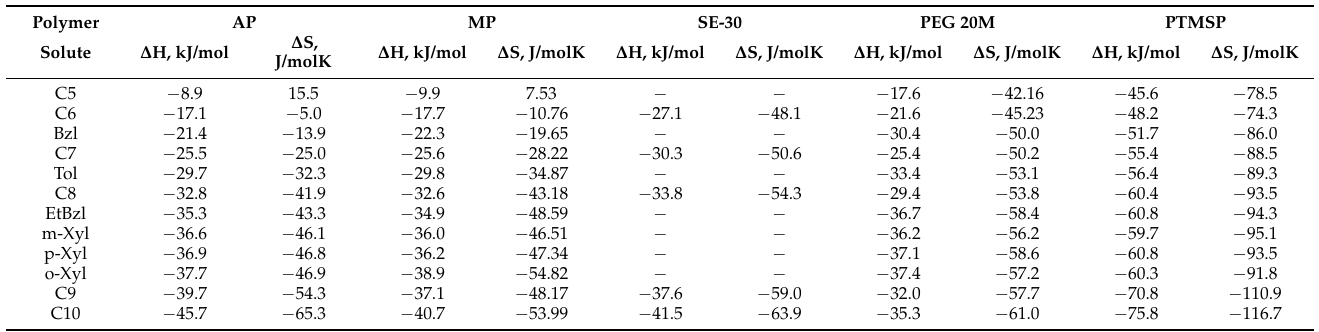
Figure 5. Correlation of the enthalpy ∆ H and entropy ∆ S of the sorption of n-alkanes during the PM stationary phase with the methylene group number for the n-alkane molecules. Table 2. Thermodynamic parameters of the adsorption of test solutes during the investigated polymeric stationary phases (r, s.d. 10%)